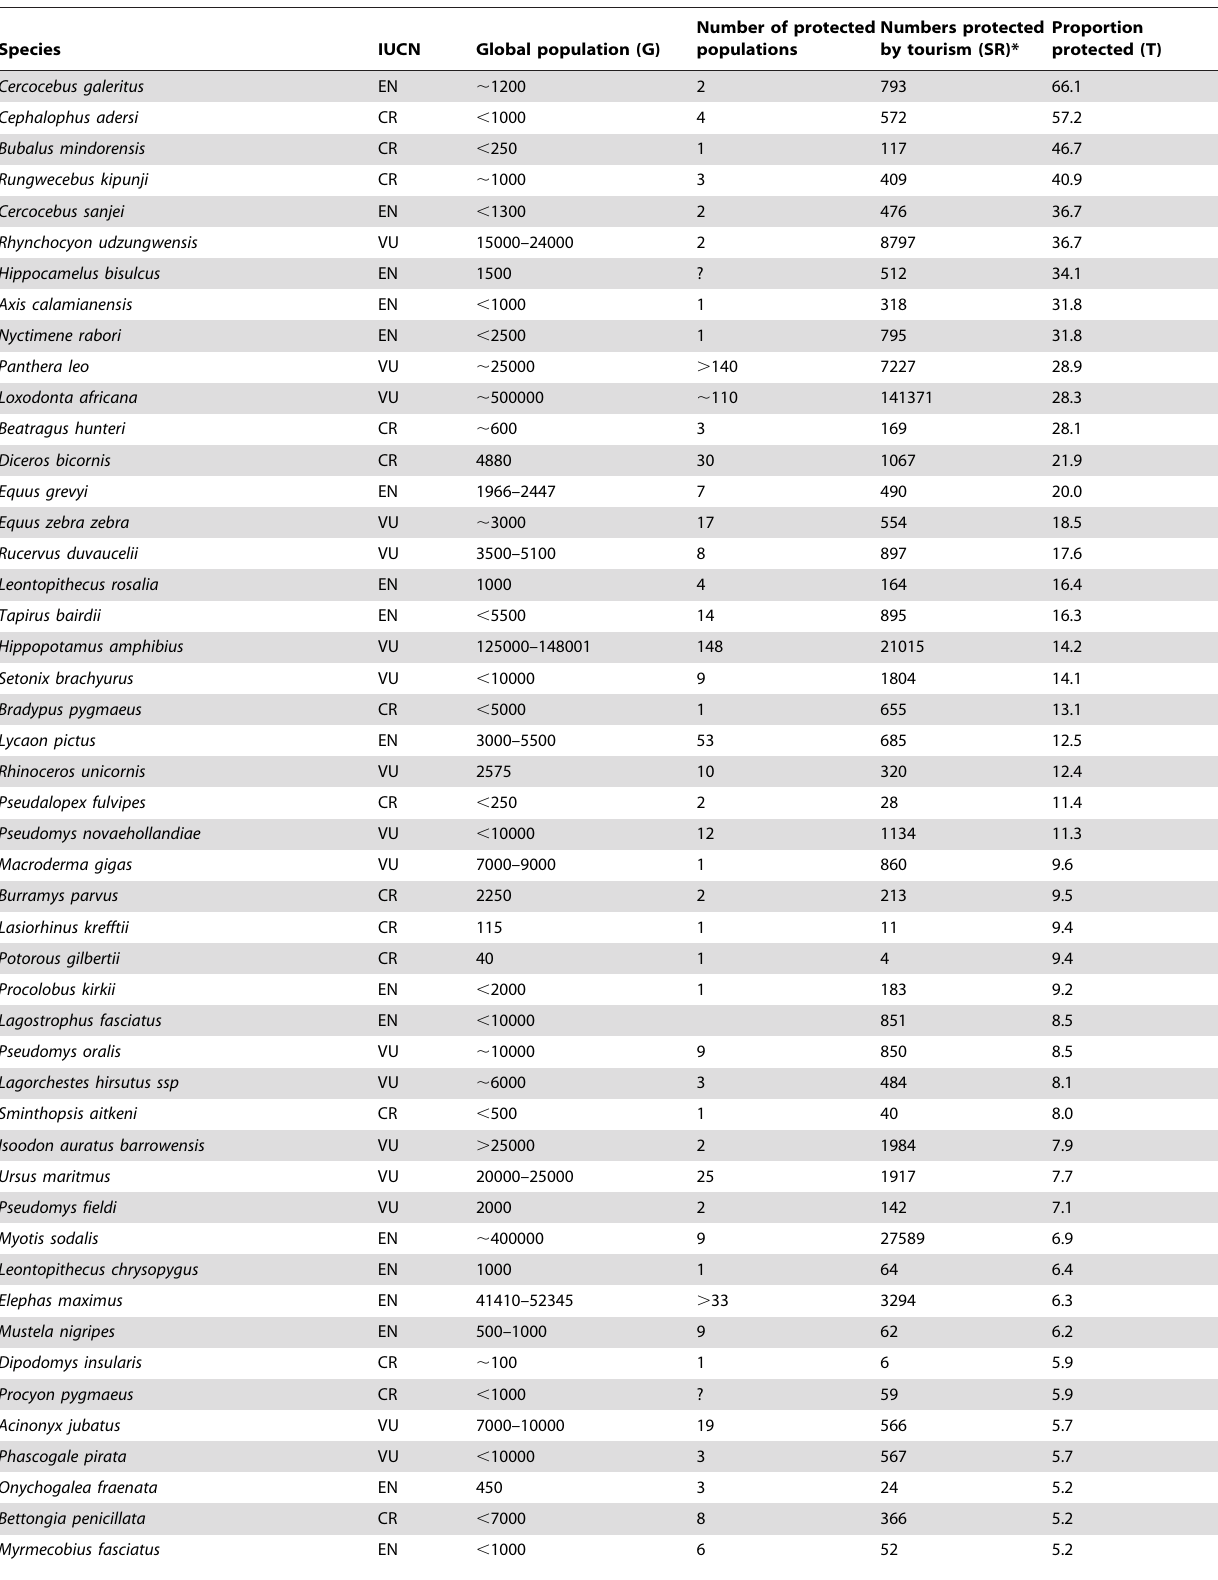
Table 1. Proportions of globally threatened mammal species conserved through tourism revenues to protected areas.